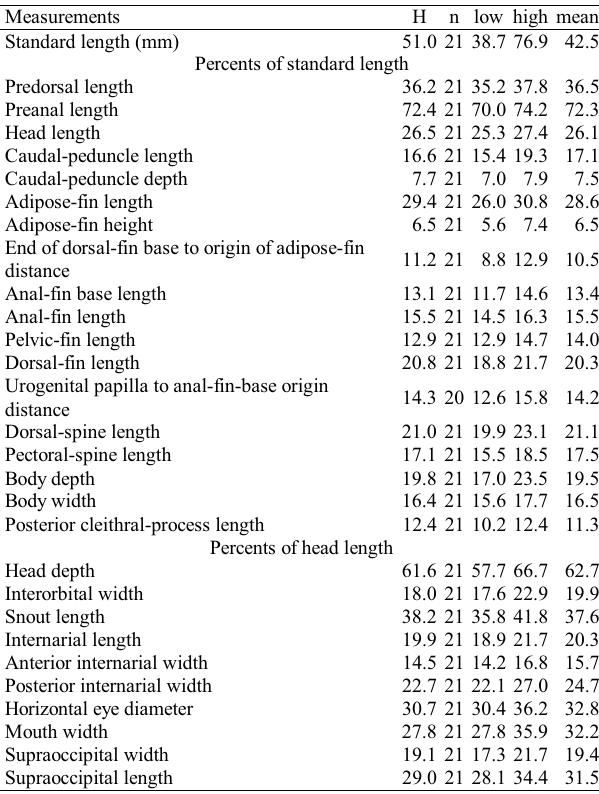
Table 3. Morphometric data of Pimelodus joannis . Range in- cludes the holotype